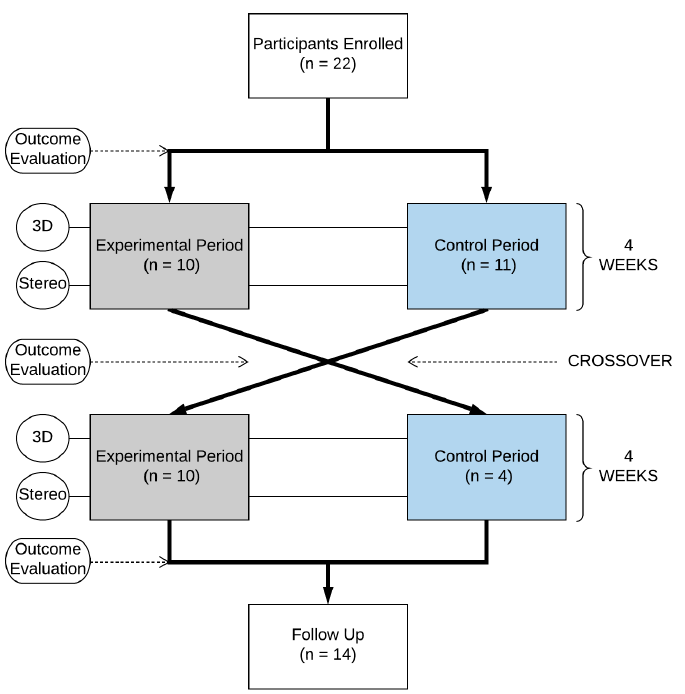
Figure 2. Consort